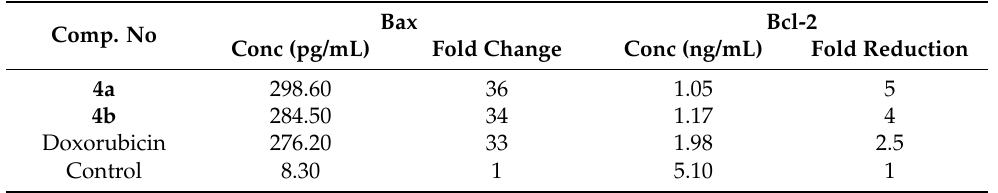
Table 5. Bax and Bcl-2 levels for compounds 4a and 4b.